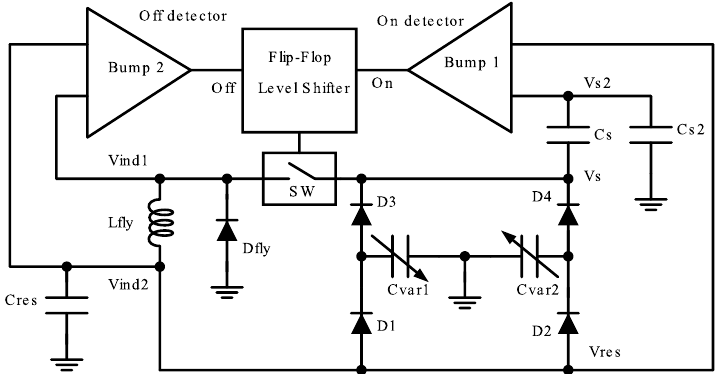
Figure 22. Simplified schematic of a double charge pump that uses two bump circuits to control the switch in the